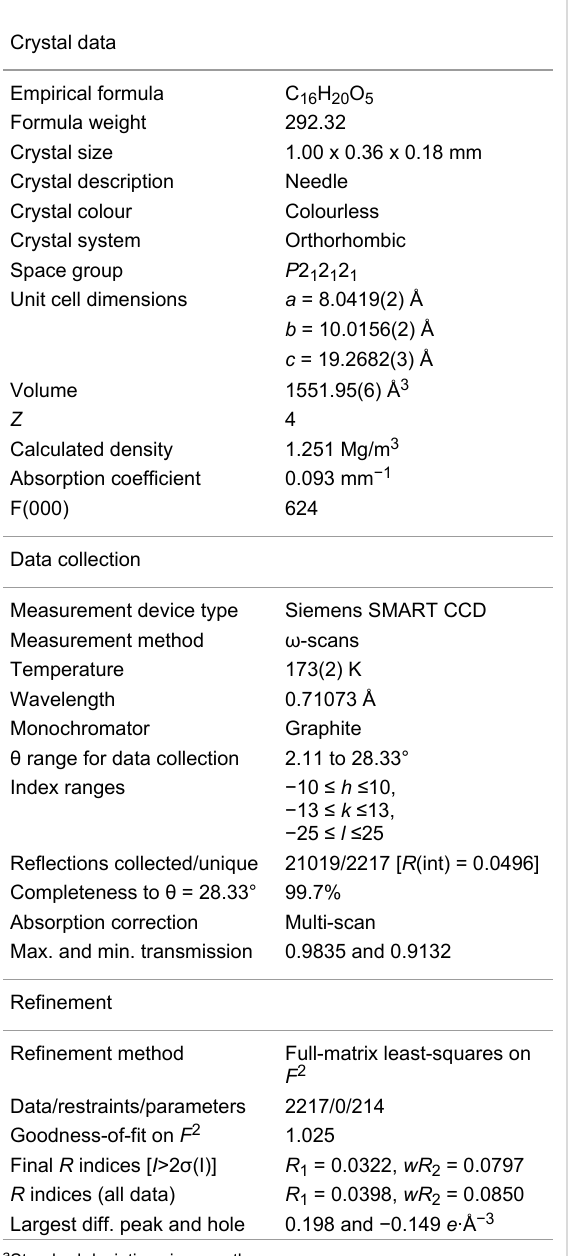
Table 3: Crystallographic and experimental data a for compound 8 .